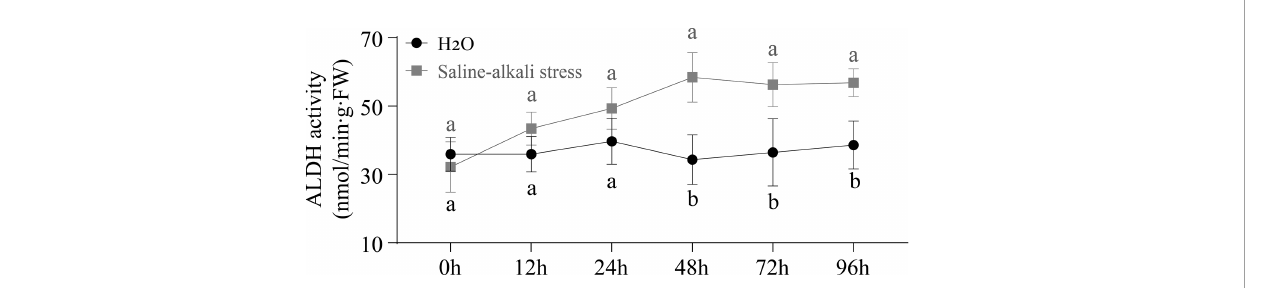
FIGURE 9 Variation curve of ALDH enzyme activity under control and saline-alkali stress treatment. Black line represents ALDH enzyme activity in H 2 O treatment at the sprout stage, while gray line represents ALDH enzyme activity in saline-alkali stress treatment.